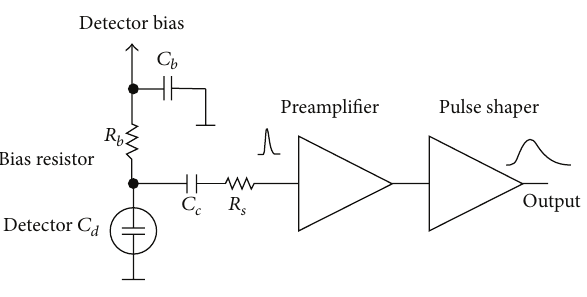
Figure 1: Typical detector front-end circuit.